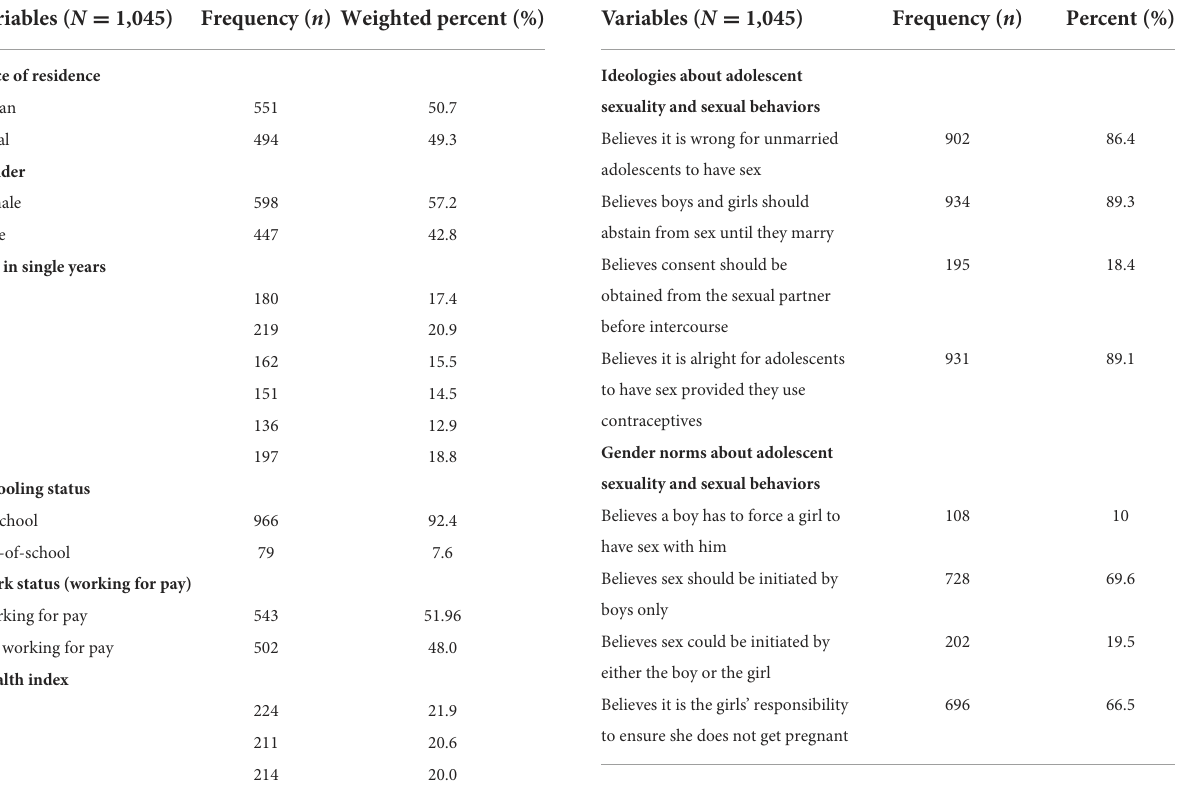
TABLE 1 Demographic characteristics of surveyed adolescents. TABLE 2 Ideologies and gender norms about adolescent